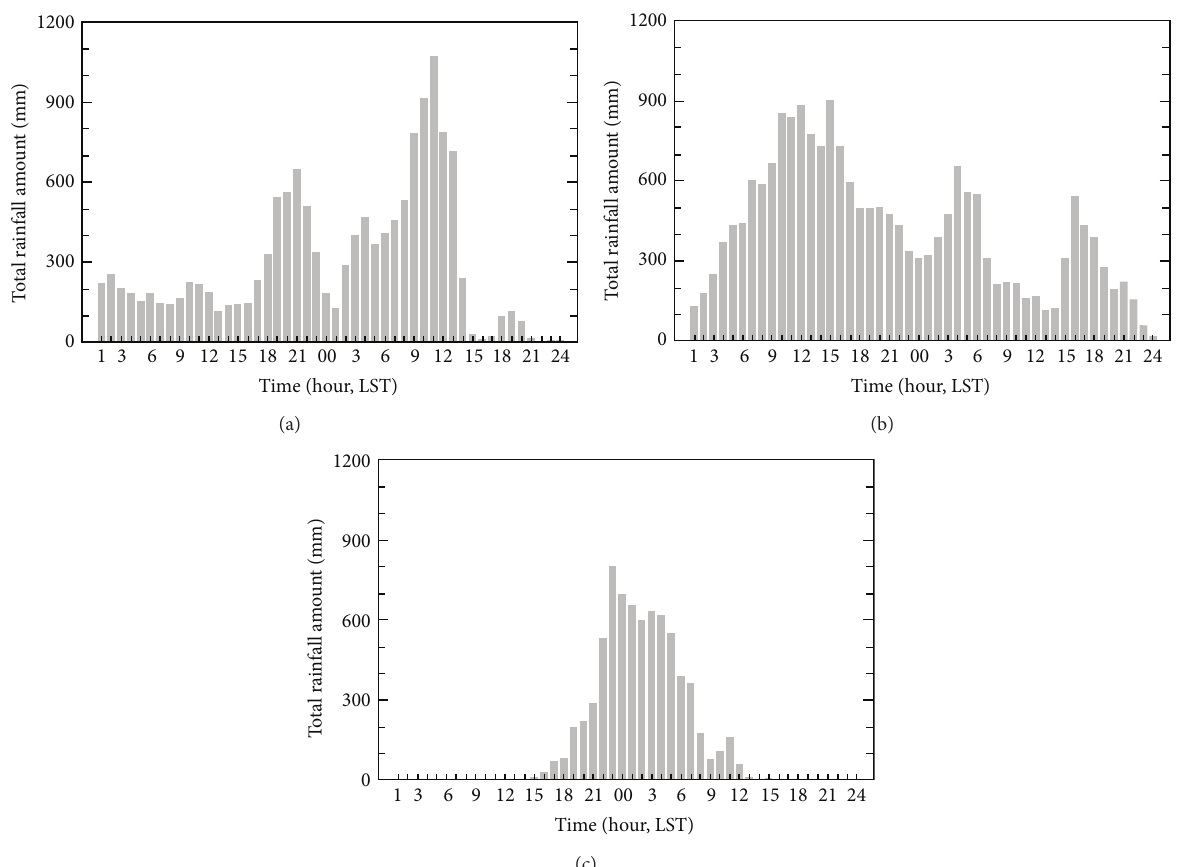
Figure 5: Time series of total rainfall amount, defined as rainfall summed over all rain gages within the radar coverage for (a) Case 1, (b) Case 2, and (c) Case 3.